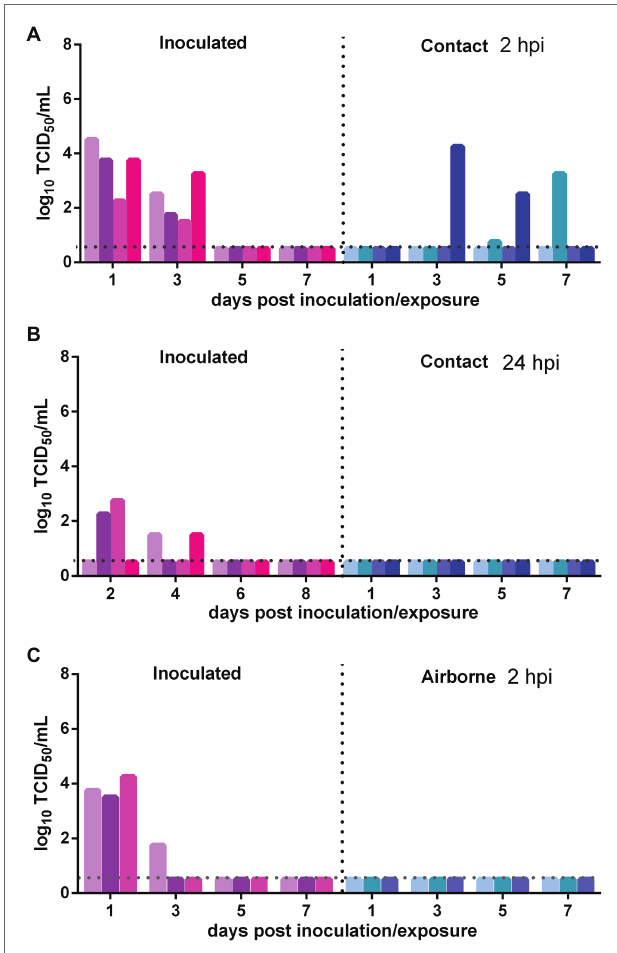
FIGURE 4 | Transmission of SARS-CoV-2 between previously infected Syrian hamsters. The dotted line represents the detection limit of the viral titer and colored bars are indicating individual animals. The time between infection and start of the transmission experiment was showed on the upper right side. (A) Viral titers detected in the nasal washes of previously infected donors inoculated with SARS-CoV-2 and previously infected contacts in the contact transmission experiment performed at 2 hpi. (B) Viral titers detected in the nasal washes of previously infected donors inoculated with SARS-CoV-2 and previously infected contacts in the contact transmission experiment performed at 24 hpi. (C) Viral titers detected in the nasal washes of previously infected donors inoculated with SARS-CoV-2 and previously infected recipients in the airborne transmission experiment performed at 2